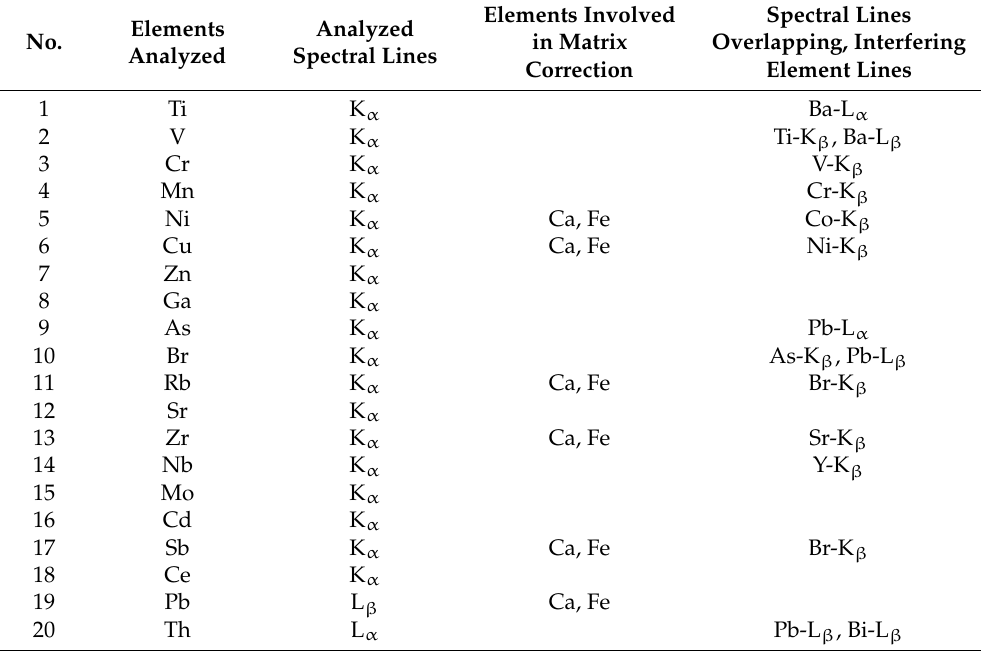
Table A1. Matrix calibration and spectral line interference.